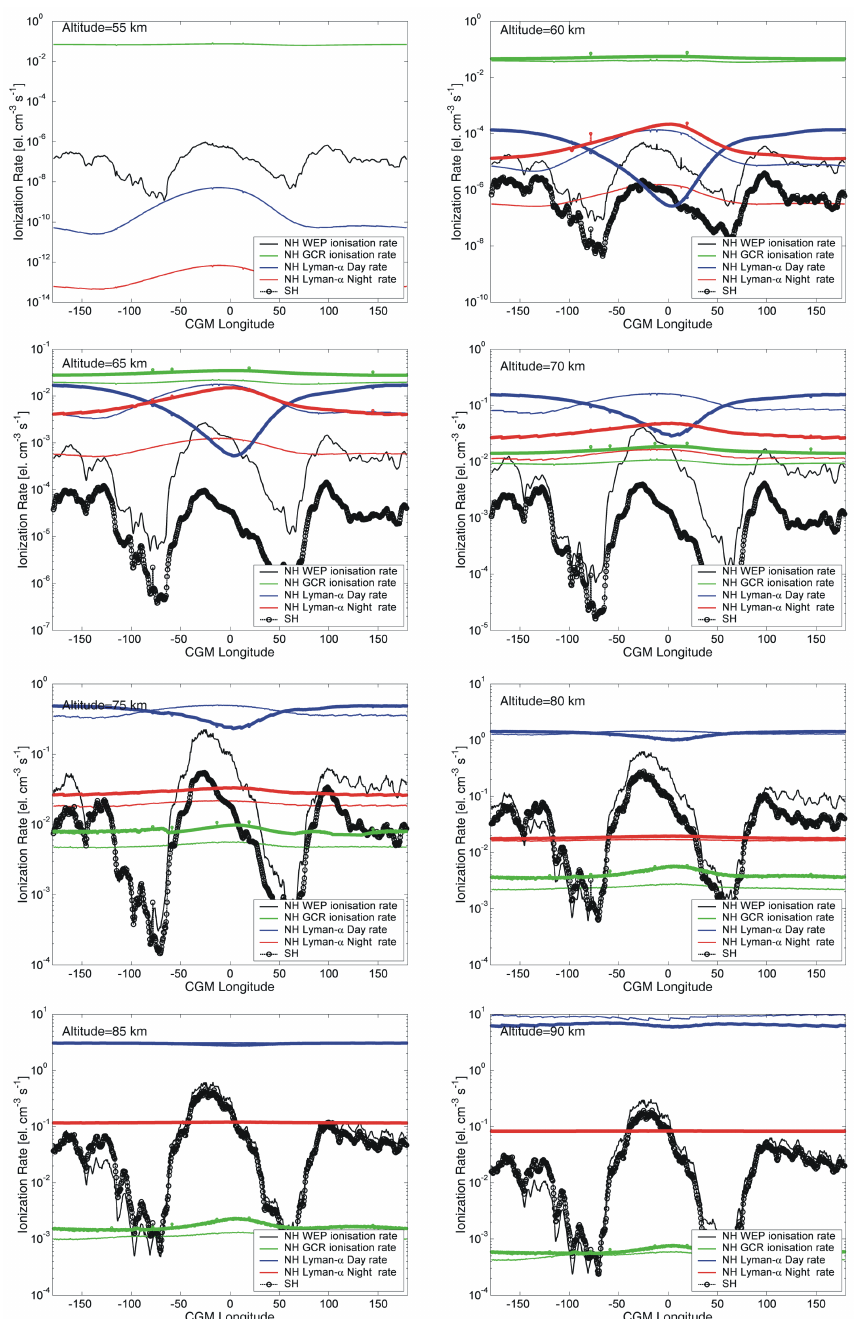
Fig. 3. Contrast between the longitudinally varying latitudinally-averaged ionisation rates for WEP (black line), GCR (green), and midday and midnight photoionisation (blue and red, respectively). Northern Hemisphere values are shown by solid lines, and Southern Hemisphere by lines with